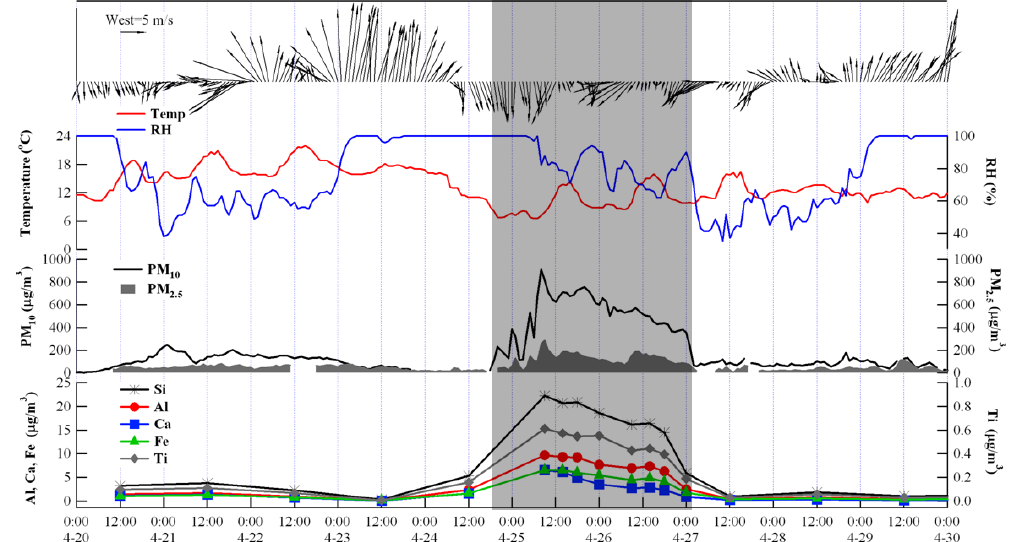
Fig. 2. Temporal variations of PM 10 , PM 2 . 5 , mineral elements (Si, Al, Ca, Fe, Ti) in PM 2 . 5 and meteorological parameters at Mt. Heng during 20 to 29 April 2009.